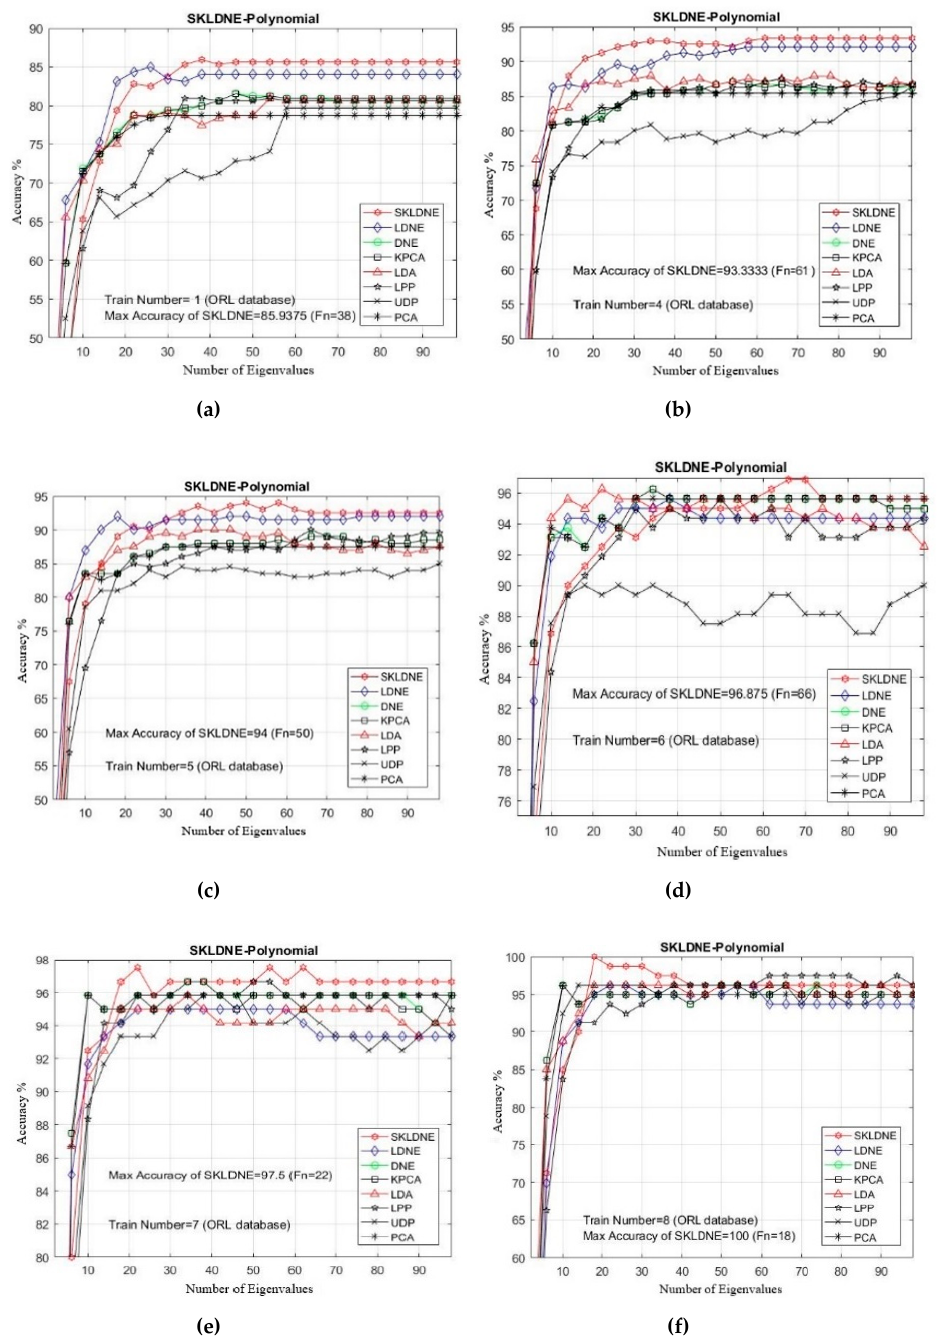
Figure 7. ( a–f ) The comparative recognition results changing the dimensionality of the transforming matrix for each given training number Tn on each data (ORL database).